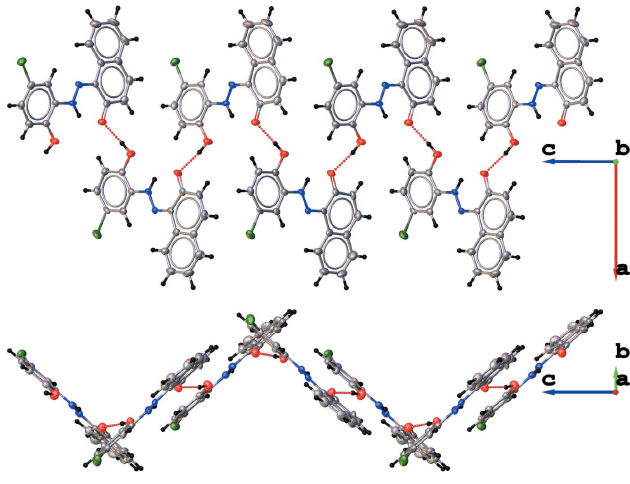
Figure 3 A partial packing diagram of the title compound showing a zigzag chain formation along the c